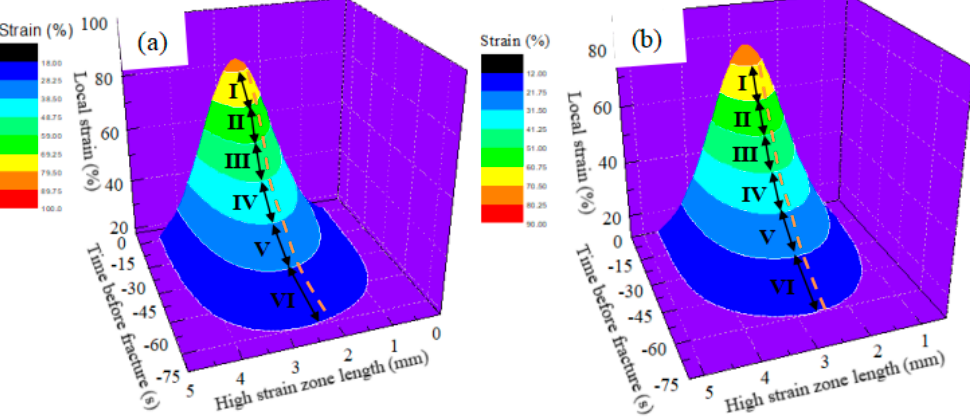
Figure 14. Strain distribution condition in high strain zones before fracture. ( a ) Transversal specimen; ( b ) longitudinal specimen.